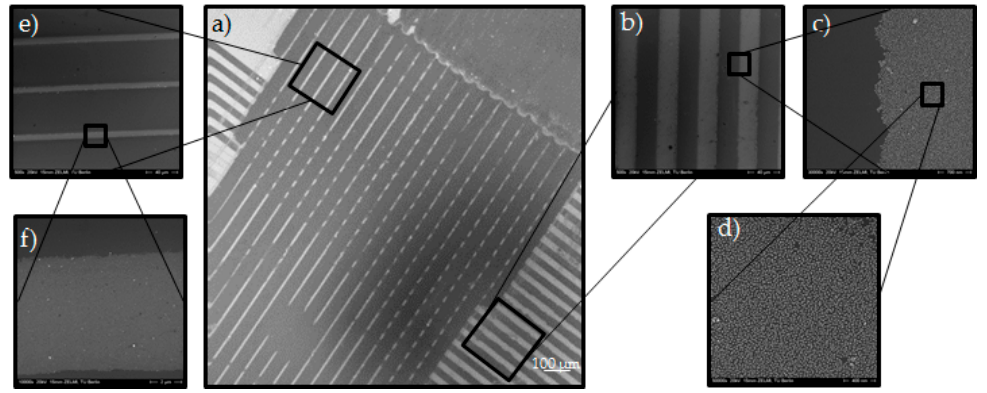
Figure 4. SEM images of a silicon wafer with micro-patterns of Au NPs (20 nm) using the wet µ-CdP procedure (size of the pattern of the poly(dimethyl)siloxane (PDMS) mold: 25 µm-25 µm-5 µm and 10 µm-20 µm-10 µm, resp.). Scale bars: ( a ) 100 µm; ( b ) 40 µm; ( c ) 700 nm; ( d ) 400 nm; ( e ) 40 µm; ( f ) 2 µm.